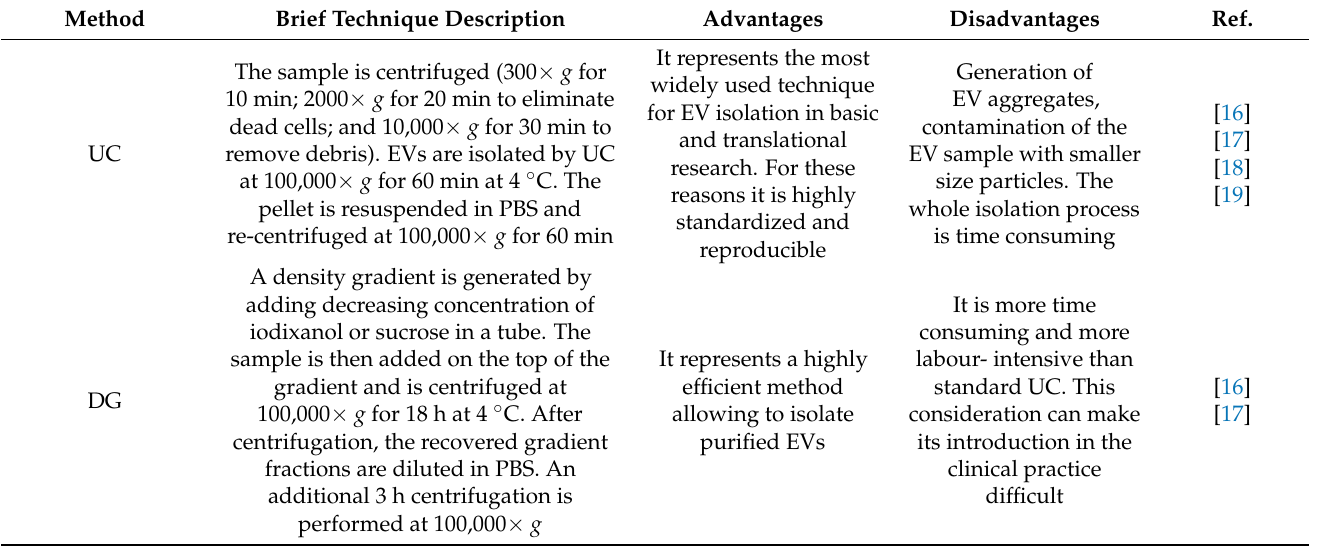
Table 1. EV isolation